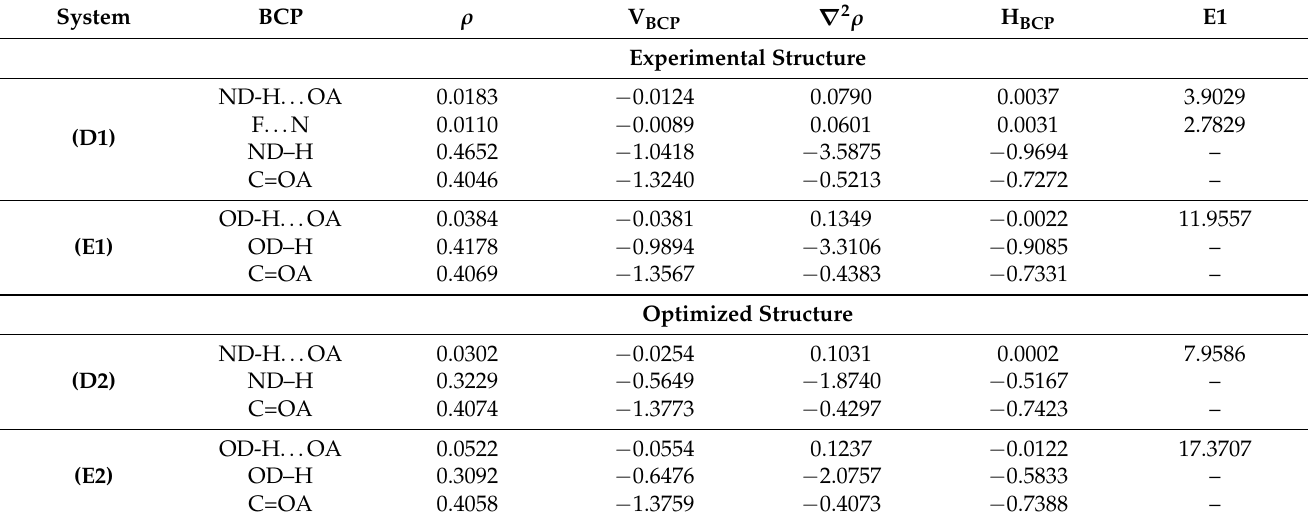
Figure 6. Potential of mean force (PMF) for the proton motion in the hydrogen bond of examined dimers with respect to the distance between the proton and its acceptor. ( D ) 2,6-difluorobenzamide and ( E ) 4-hydroxybenzoic acid. Table 2. QTAIM-derived properties at BCPs for examined dimers from the structure deposited in the CCDC database and after geometry optimization at the ω B97XD/def2-TZVP level of theory. E1 is a bond energy based on the Espinosa model, given in kcal * mol − 1 . Units of gathered quantities are as follows: electron density, ρ BCP , is given in e · a − 3 atomic units and the Laplacian of electron 0 density, ∇ 2 ρ BCP , is in e · a − 5 units. V BCP stands for BCP potential energy density and H BCP denotes 0 the energy density at the